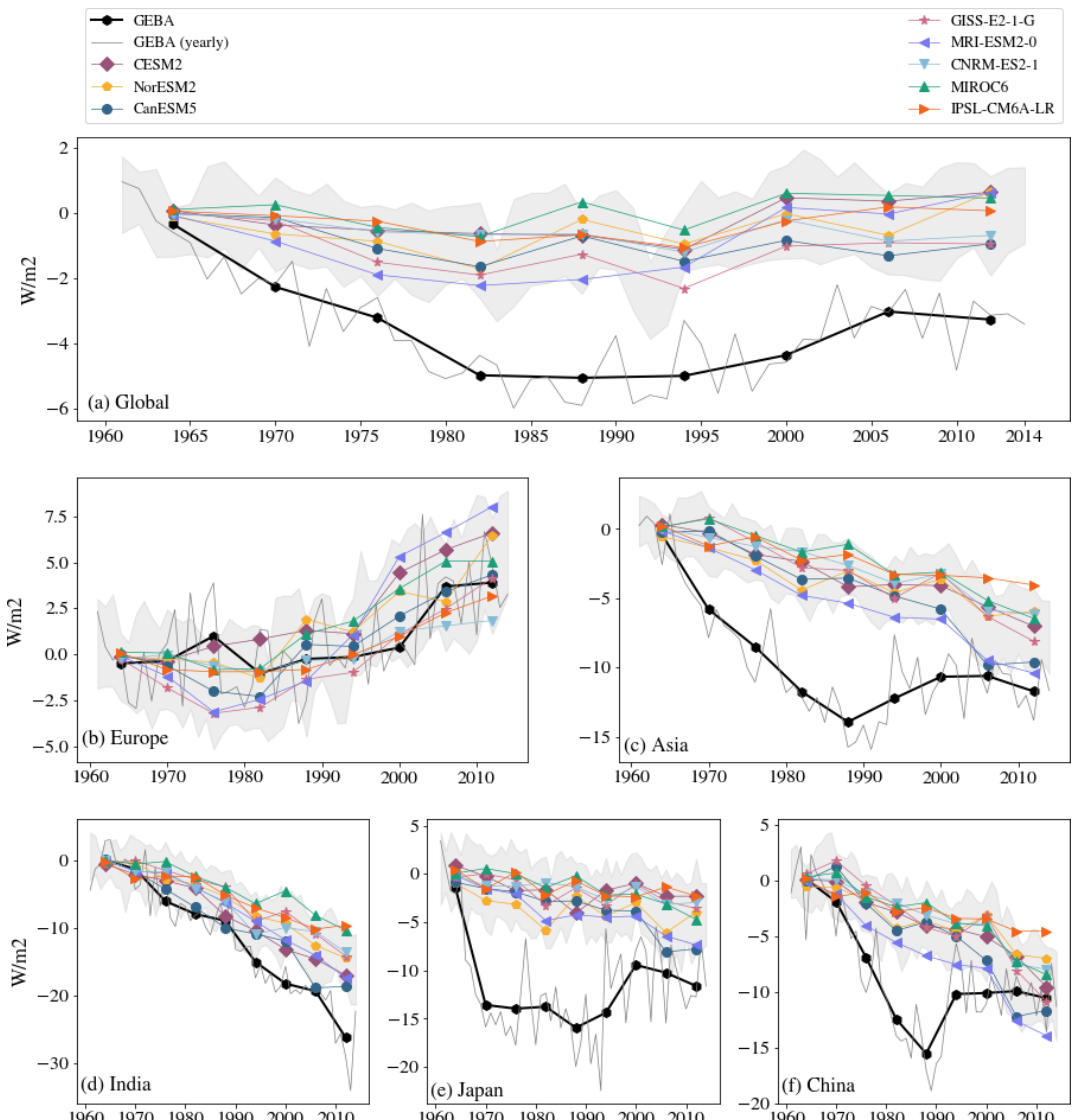
Figure 2. Six-year averages of the SDSR anomaly at the surface for GEBA and eight Earth system models. Results are co-located at (a) all GEBA stations (1487), (b) European (503), (c) Asian (311), (d) Indian (15), (e) Japanese (100), and (f) Chinese (119) stations. Numbers in parentheses are the number of ground stations in the respective region. The entire 54-year period has been divided into intervals of 6 years and then averaged together to make nine data points as shown by the markers. The grey shading represents 1 standard deviation from the yearly total ensemble